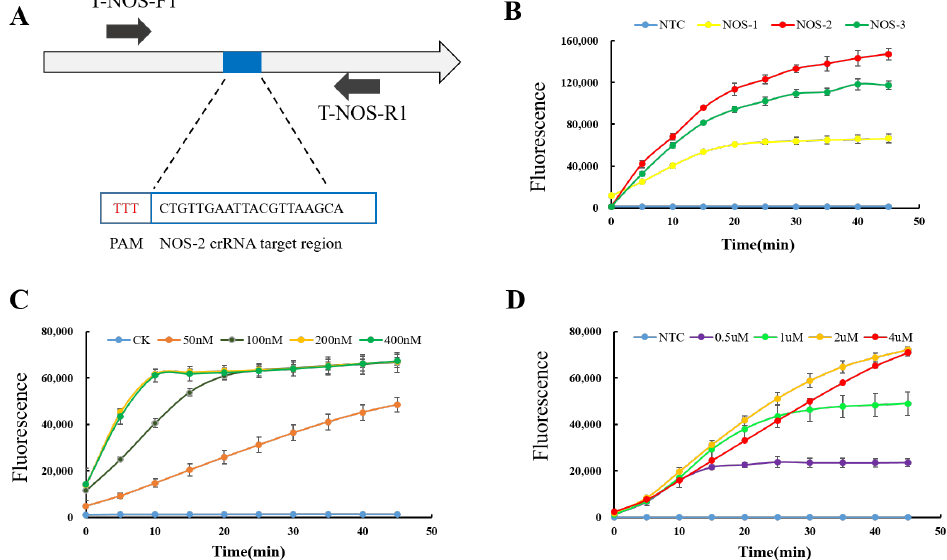
Figure 3. Optimisation of the CRISPR/Cas12a detection system for T-nos detection. ( A ) For crRNA design, three sites based on T-nos conserved sequences were screened, and upstream and downstream primer sites corresponding to T-NOS-F1/R1 were identified. ( B ) Cas12a assays using crRNA NOS-1, NOS-2 and NOS-3. NTC, no target DNA control. The x-axis shows the reaction time, and the y-axis shows the fluorescence signal. ( C ) Comparing the Cas12a assay using different concentrations of the same crRNA. ( D ) Comparing the Cas12a assay using different concentrations of fluorescent probes.